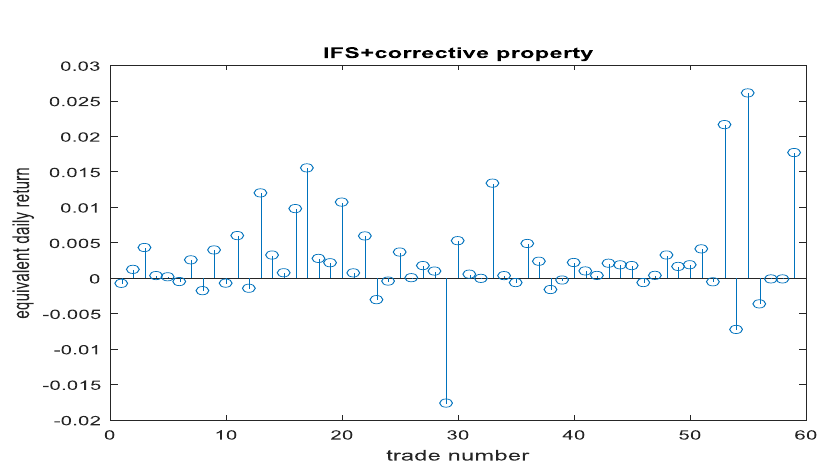
Figure 5. Equivalent daily return for each situation